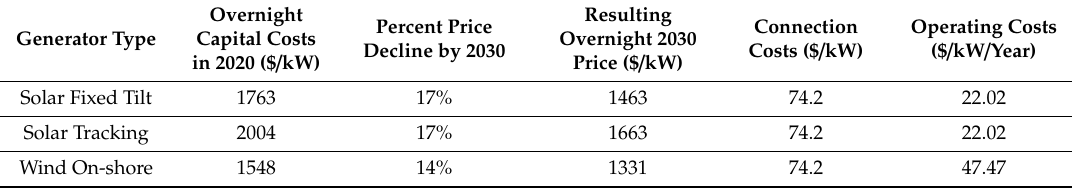
Table 12. Cost Factors for New Renewable Generators.